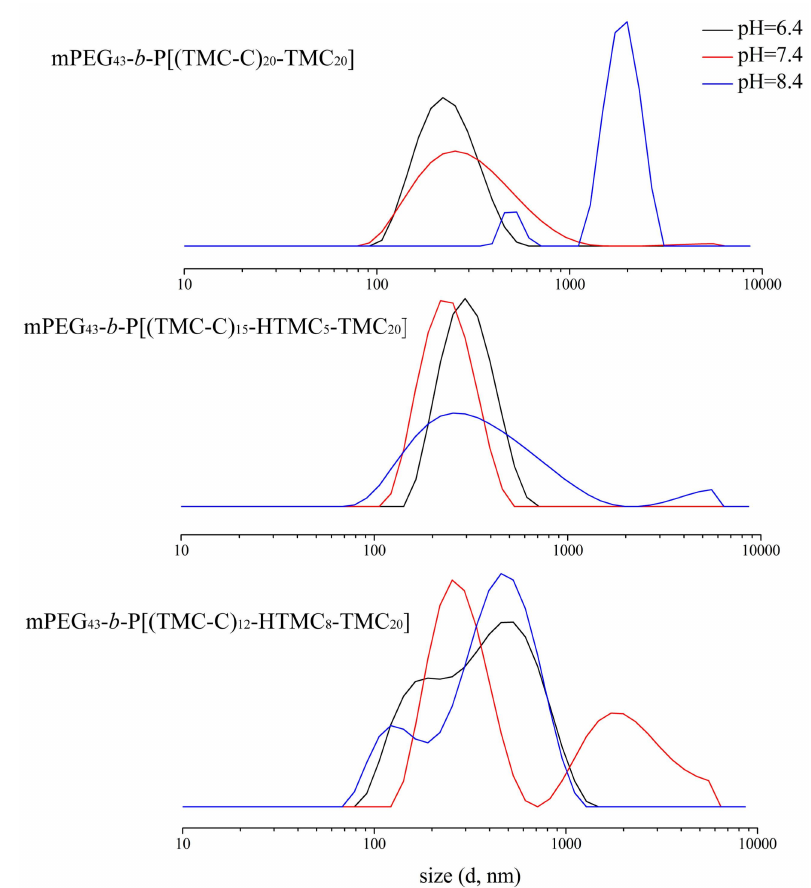
Figure 9. pH-responsive particle sizes of the DOX-loaded copolymer micelles at 37 ◦ C in phosphate buffer (pH = 6.4, 7.4, 8.4) by